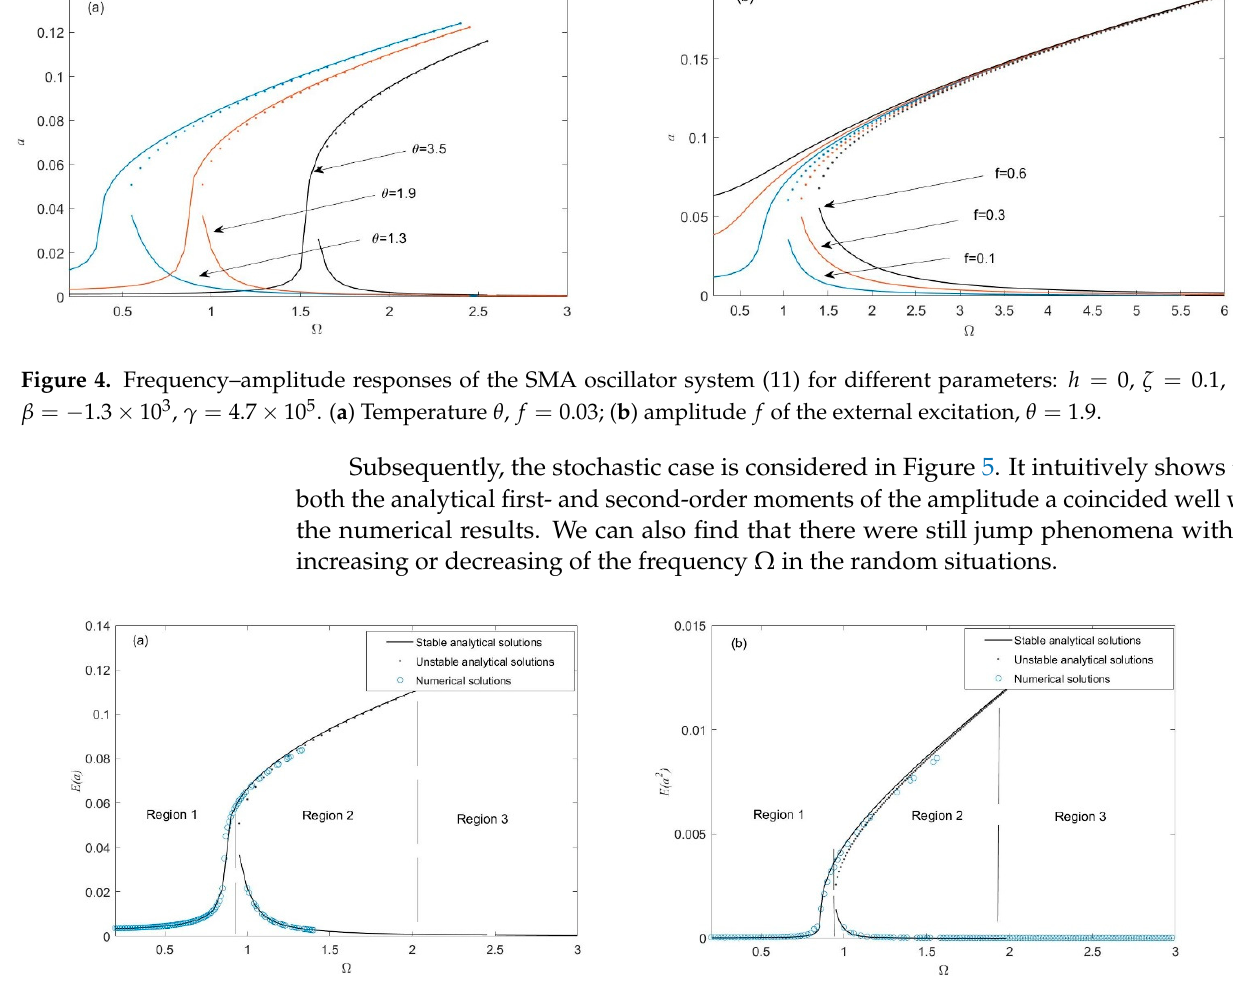
Figure 5. Frequency–amplitude responses of the stochastic SMA oscillator system (11) with the fixed system parameters ζ = 0.1, β = − 1.3 × 10 3 , γ = 4.7 × 10 5 , h = 0.06, f = 0.03, θ = 1.9. ( a ) First-order moment of amplitude a ; ( b ) second-order moment of amplitude a : “-” stable analytical solutions, “.”unstable analytical solutions, “o”numerical solutions.